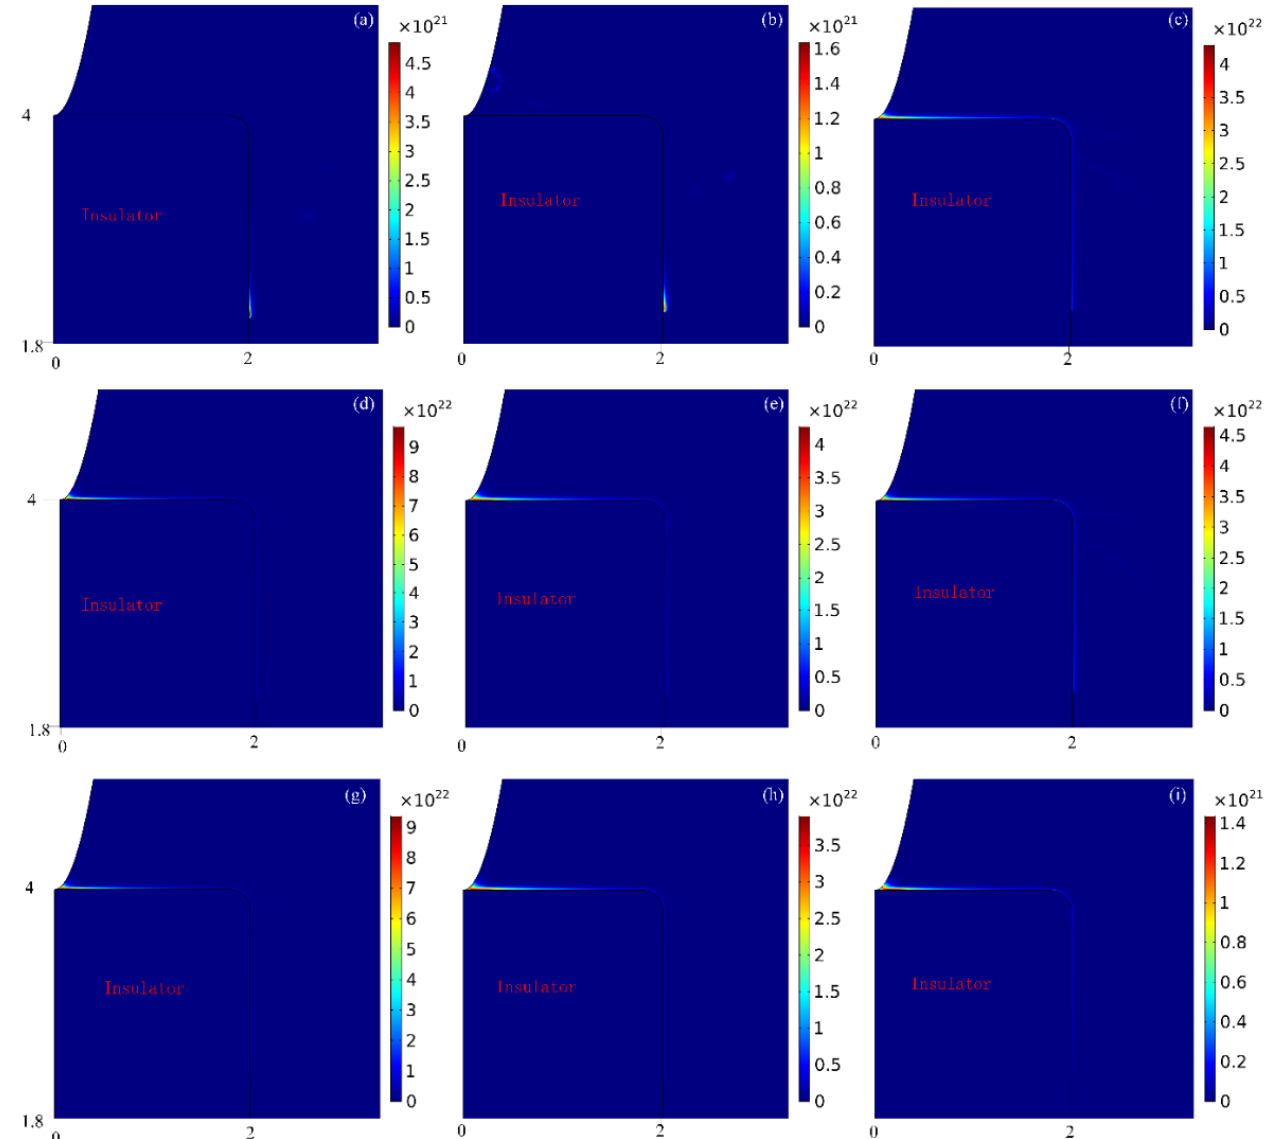
first two models. Figure 8d–f are the distribution of negative ions in model A, B and C, respectively. The maximum values of negative ion concentration on the insulator surface (cid:0) (cid:0) (cid:0) (cid:1) (cid:1) (cid:1) are 9.36 × 10 22 , 3.75 × 10 22 and 1.43 × 10 21 . The negative ions in 1/ m 3 1/ m 3 1/ m 3 the model C is much smaller than the other two models, and the difference between the negative ion concentrations in the model A and B is not large.